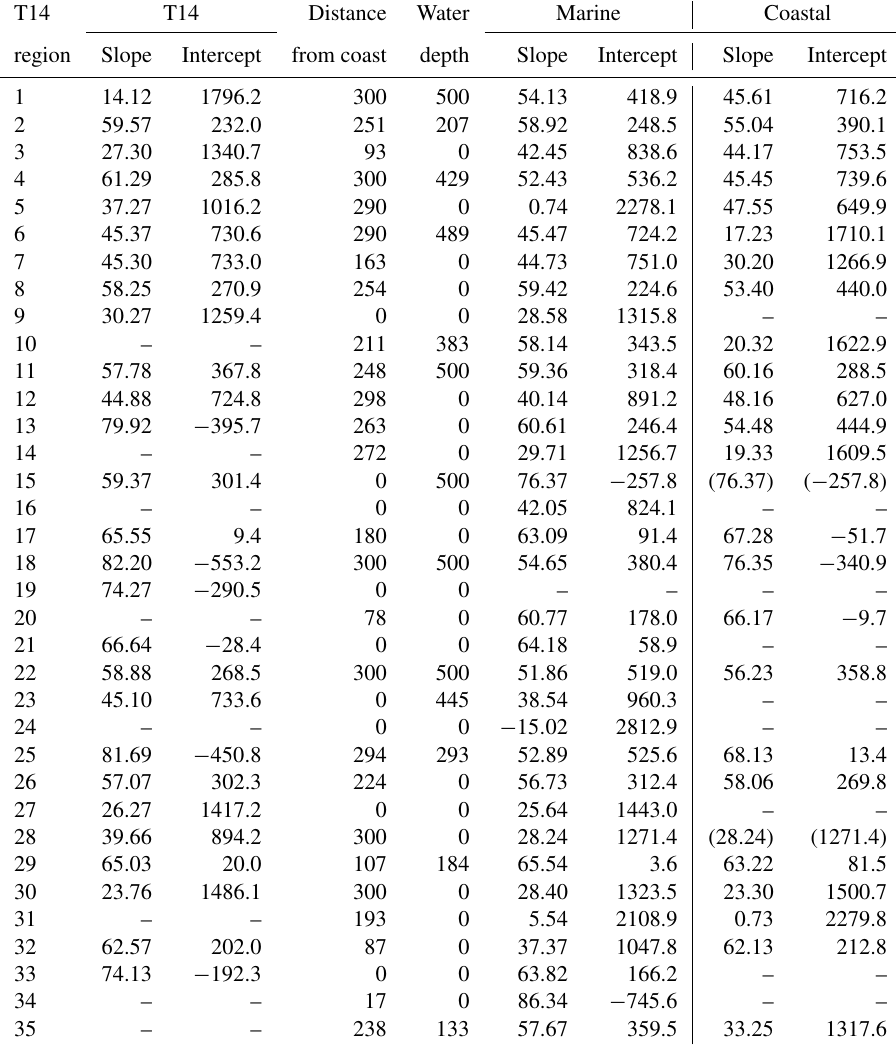
Table 3. Slope and intercept in each region defined by Takahashi et al. (2014) (T14). Original coefficients quoted by T14 are labelled T14, and reparameterised coefficients are given for coastal and marine subregions, where a point is marine if both distance from coast and water depth are greater than their regional